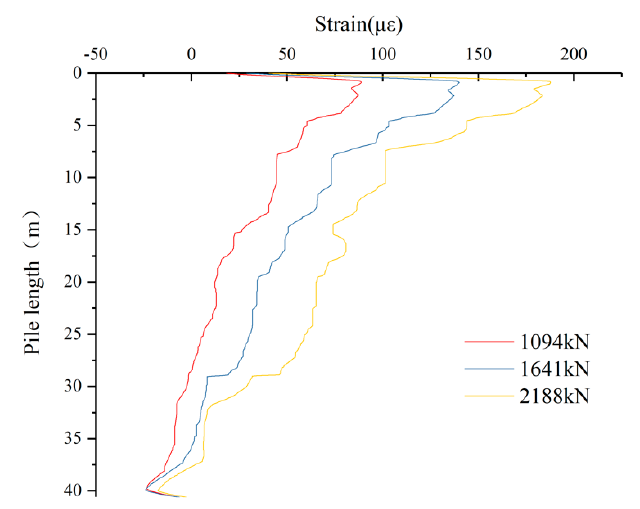
Figure 7. Percentile-filter smoothing signal.